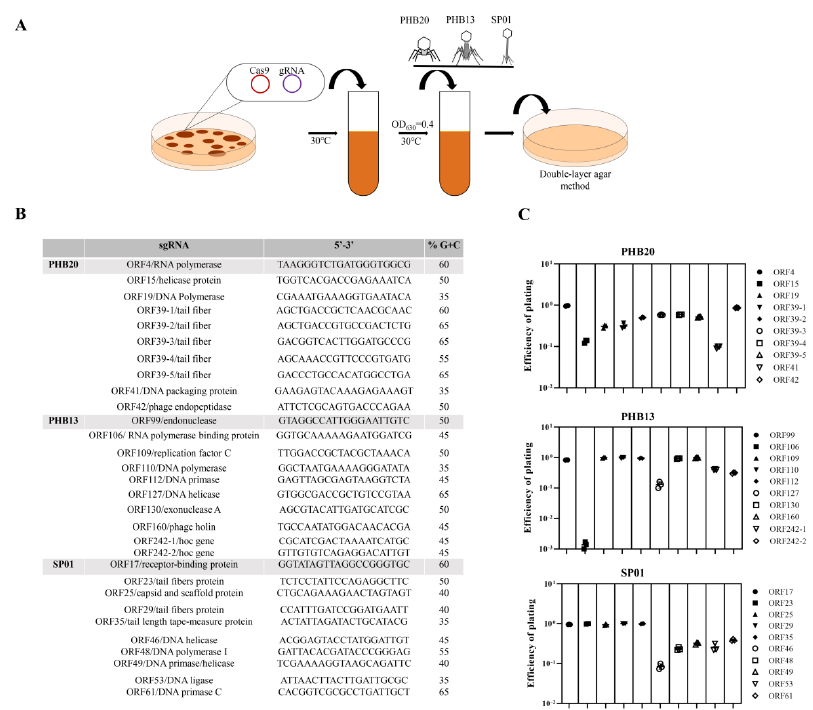
Figure 1. Efficiency of the no − SCAR system protection against phage infection. ( A ) Schematic overview of the no − SCAR − system − based phage genome editing. ( B ) The spacer sequences from different phages. ( C ) The efficiency of plating was determined by a plaque assay. This experiment was performed in triplicate: PHB20 (Genbank no. MN481366), PHB13 (Genbank no. MK573636), and SP01 (Genbank no. KY114934). Different symbols represent different protospacer sequences.